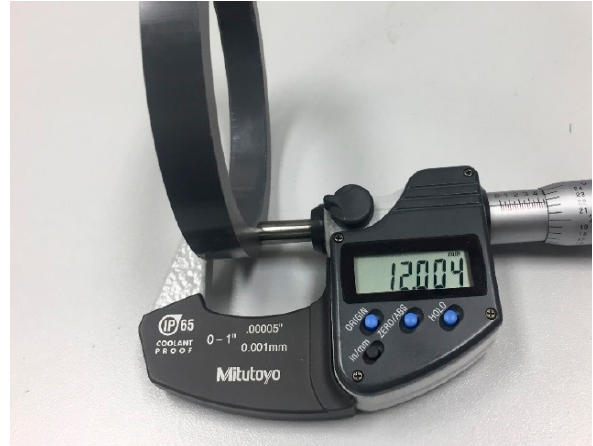
Figure 2. Specimen sample.